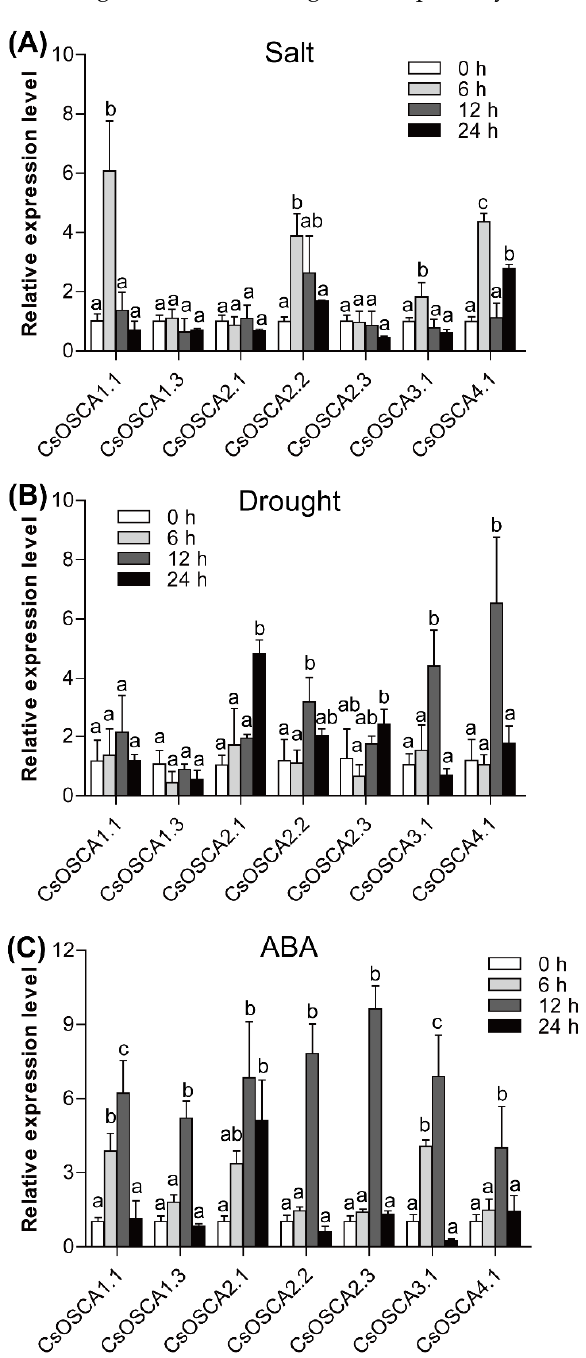
Figure 6. Relative expression analysis of seven CsOSCA genes under salt ( A ), drought ( B ), and ABA ( C ) treatments based on qRT ‐ PCR. Error bars represent standard deviation (SD). Different lowercase letters indicate statistically significant variations in expression at p < 0.05.